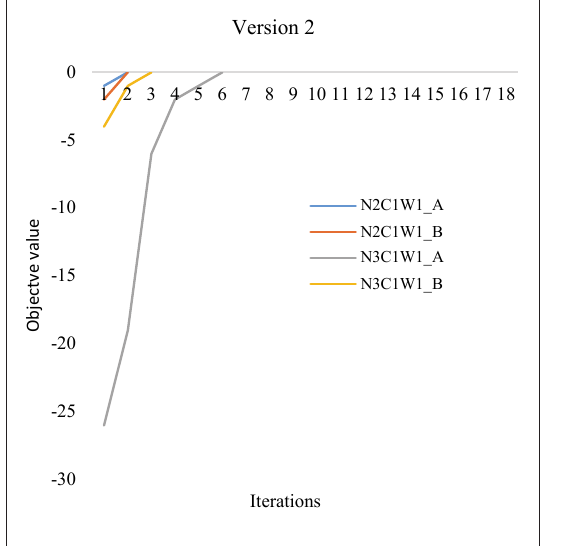
Fig. 9. Performance of version 2 algorithm for sample datasets with 100 and 200 objects